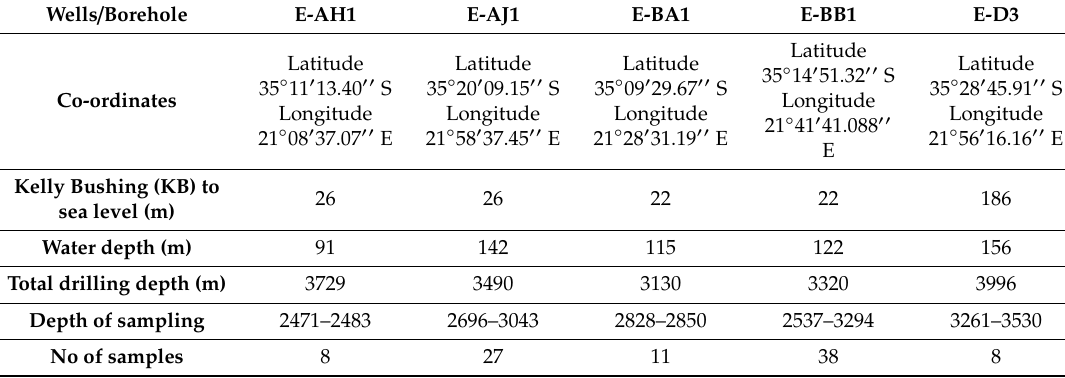
Table 3. Locations and total drilling depth of the studied exploration